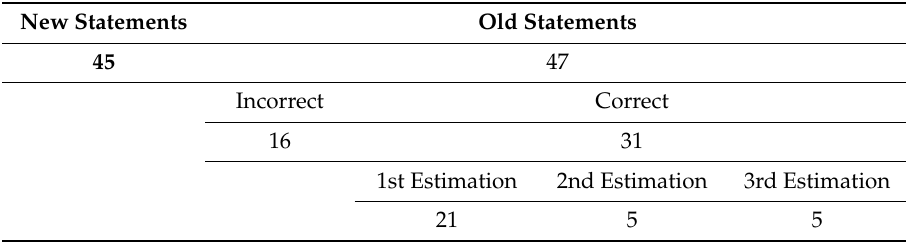
Table 1. Results of the game played online on the website. The table lists the total number of times of the game play. The game was played for a total of 92 times, out of which it was played for 45 times on new statements (not in the database) and 47 times on old statements (in the database). For the statements already in the database, the table also lists the number of times that they were estimated incorrectly and correctly. For the correctly estimated statements the table lists the number of times the statements were the first, second, or third